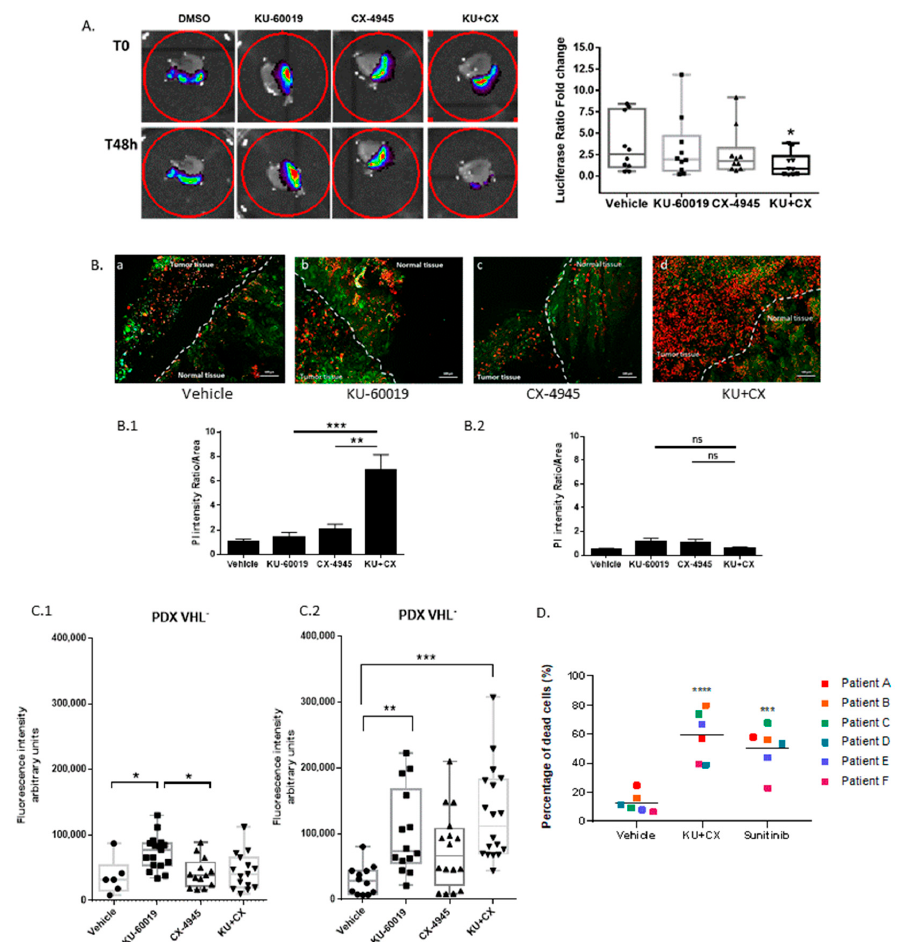
Figure 7. Ex vivo models as pre-clinical tests for drug combination efficacy. ( A ) Tissue slices derived from 786-O-Luc xenografts were imaged for Luciferase activity before treatment and 48 h after incubation with indicated molecules (dots: vehicle, square: 10 µ M ATM triangle: 10 µ M CX-4945, inverse triangle: 10 µ M ATM + 10 µ M CX-4945). Right panel: Luciferase ratio fold changes (Treated versus Control) after 48 h of treatments (* p < 0.05). Mann–Whitney test, n = 10.